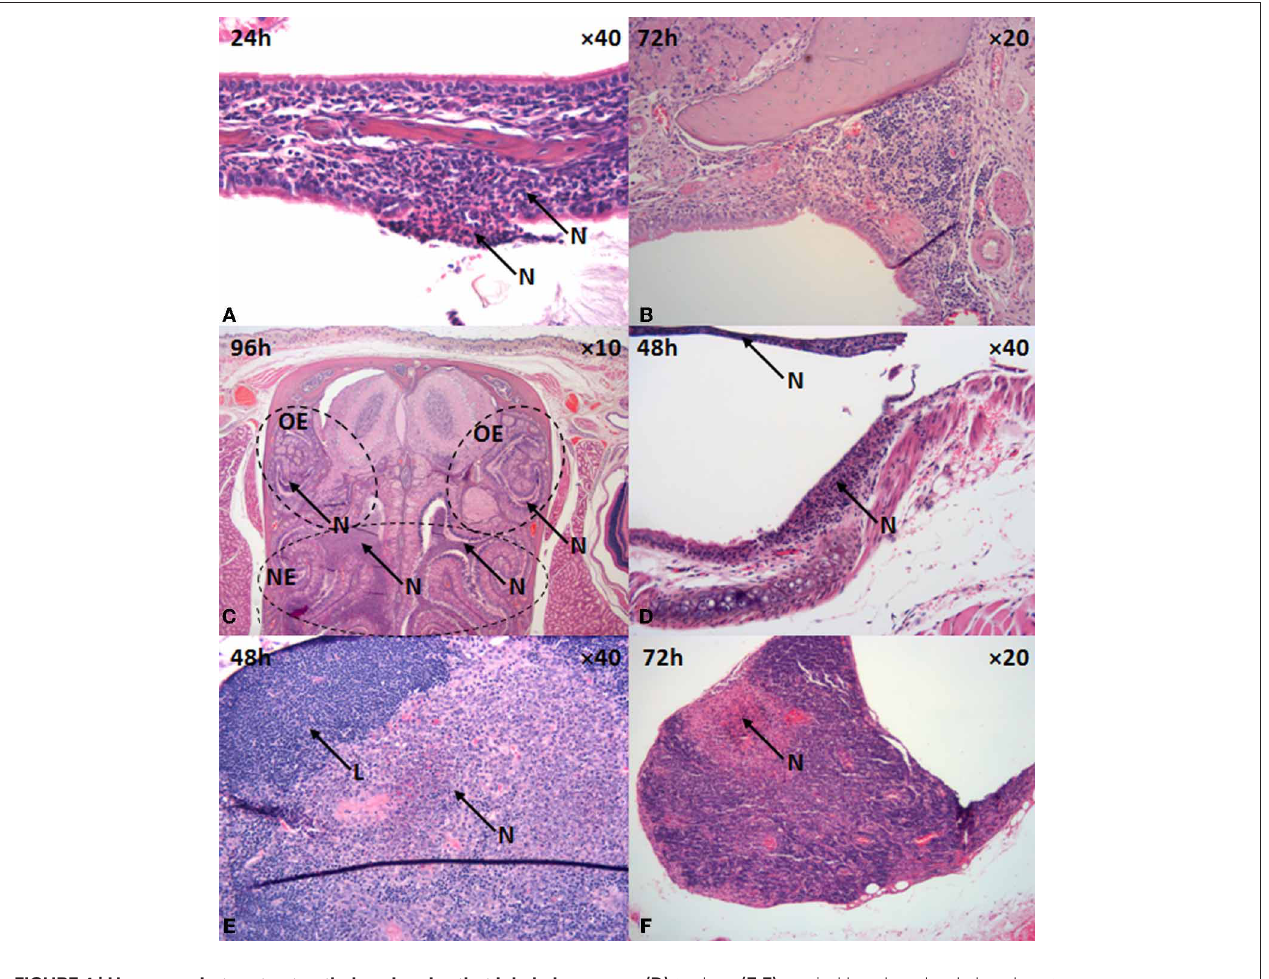
(D) trachea, (E,F) cervical lymph nodes. L, lymphocyte, N, suppurative inflammation, NE, nasal epithelium, OE, olfactory